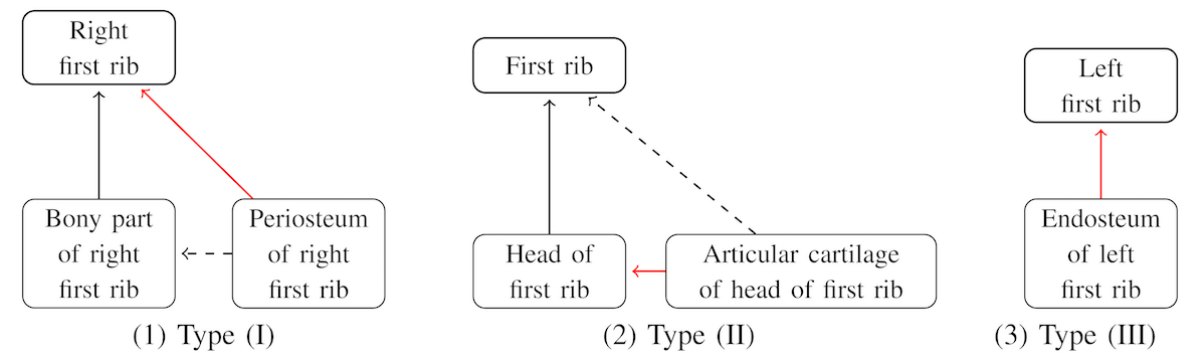
Figure 5. Types of unexpected part-of relations that do not exist in the Foundational Model of Anatomy (FMA). Black solid arrows represent relations in the FMA successfully predicted by the model. Red arrows represent relations predicted by the model but not in FMA. Dashed arrows represent relations in FMA that were missed by the model. (1) Example of the first type of predicted relations; (2) example of the second type of predicted relations; (3) example of the third type of predicted